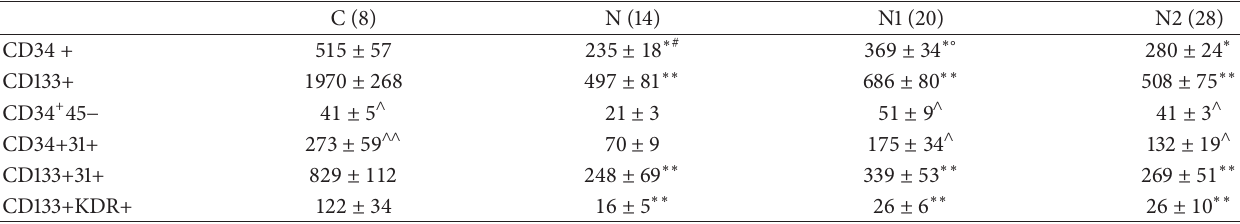
Table 2: Cytofluorimetric classes in all studied groups (mean ± SE): nonmacrovascular neuropathic diabetic patients without foot lesions (N); nonmacrovascular neuropathic diabetic patients with foot lesions (N1); macrovascular neuropathic diabetic patients with ulcers/lesions/osteomyelitis of the lower limbs (N2). Healthy controls